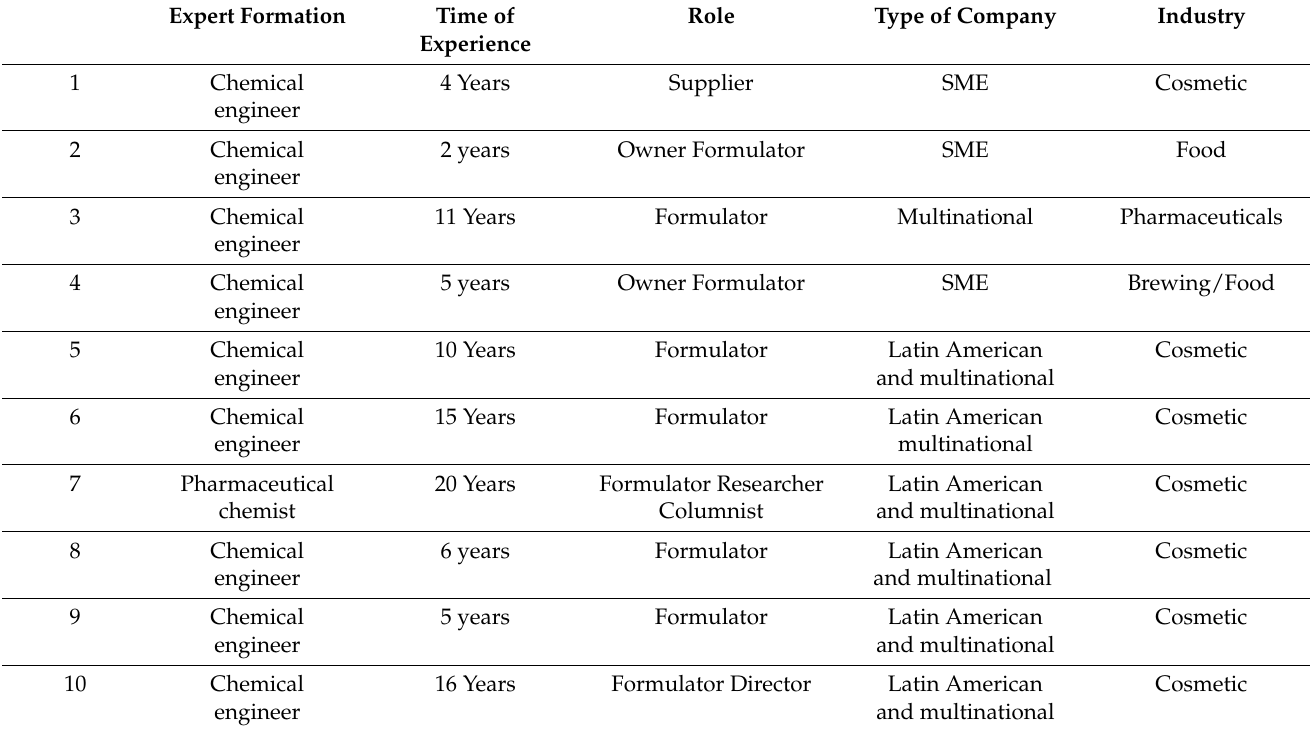
Table 2. Profile of the interviewed